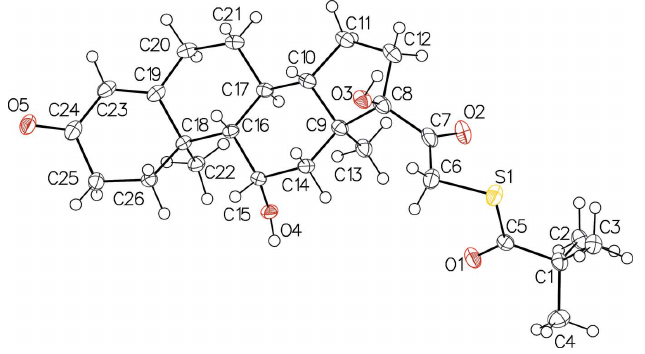
Figure 2 ORTEP view of polymorph ( II ). Displacement ellipsoids are drawn at the 30% probability level. The minor component of the disorder is omitted for clarity.